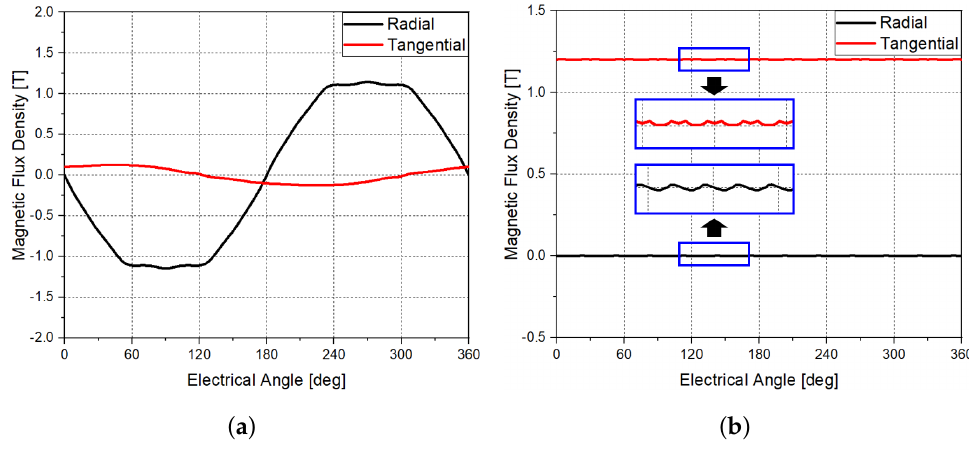
Figure 6. Sample of R-T flux density waveform at ( a ) Point1 (stator) ( b ) Point2